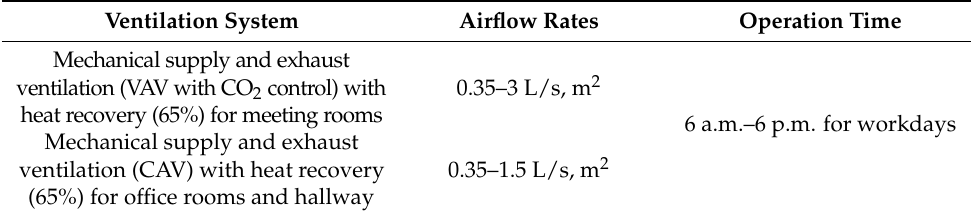
Table 2. Ventilation system description.